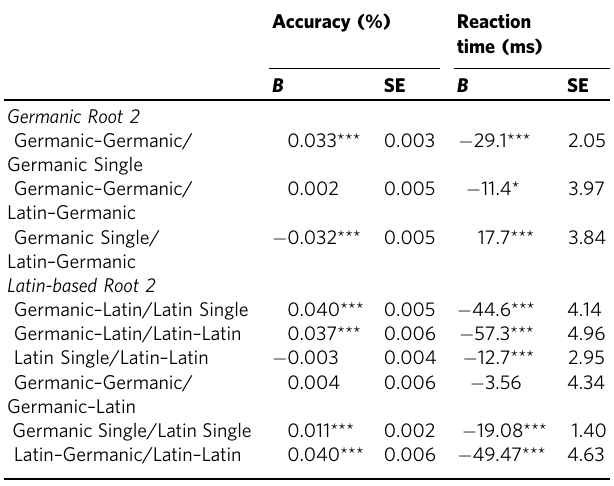
Table 3 English lexical project: simple effect/contrast analysis for naming